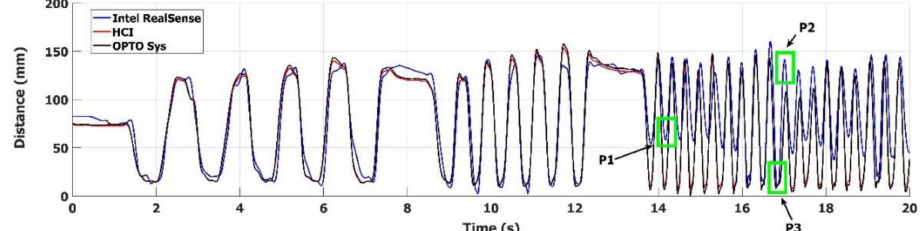
Figure 9. Comparison of the Intel RealSense ® and the HCI trackers during the execution of FT task movements. The figure shows the estimated distance between the thumb and the index fingers measured by the Intel RealSense ® tracker (blue solid line), the HCI tracking algorithm (red solid line) and the optoelectronic reference system (black solid